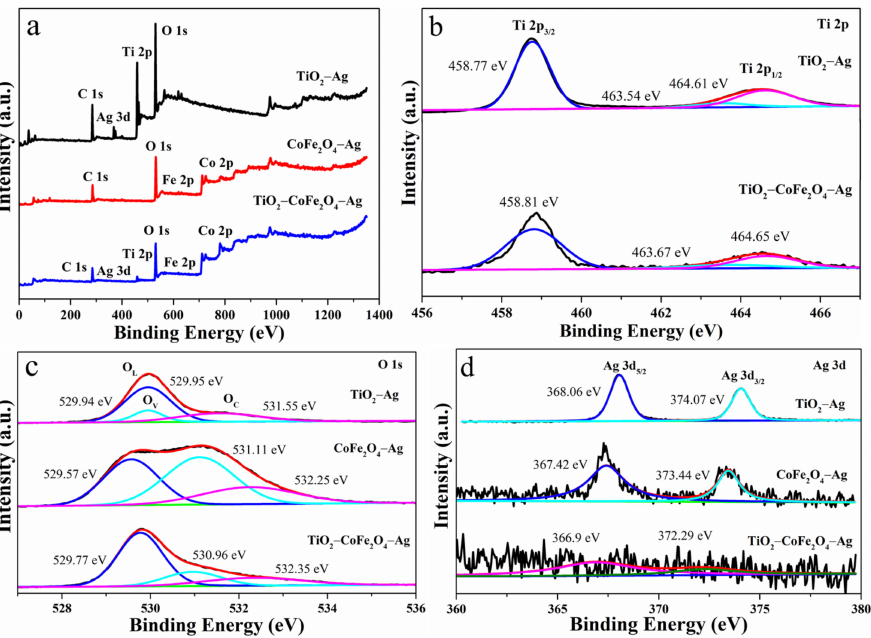
Figure 3. X-ray photoelectron spectroscopy (XPS) spectra: ( a ) total spectrum, ( b ) Ti 2p, ( c ) O 1s, and ( d ) Ag